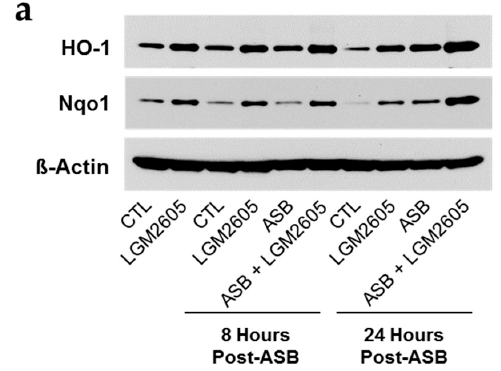
Figure 7. Cont. Figure 7. Cont.